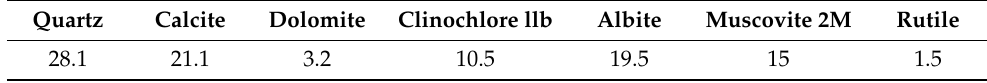
Table 2. Mineral component analysis results.